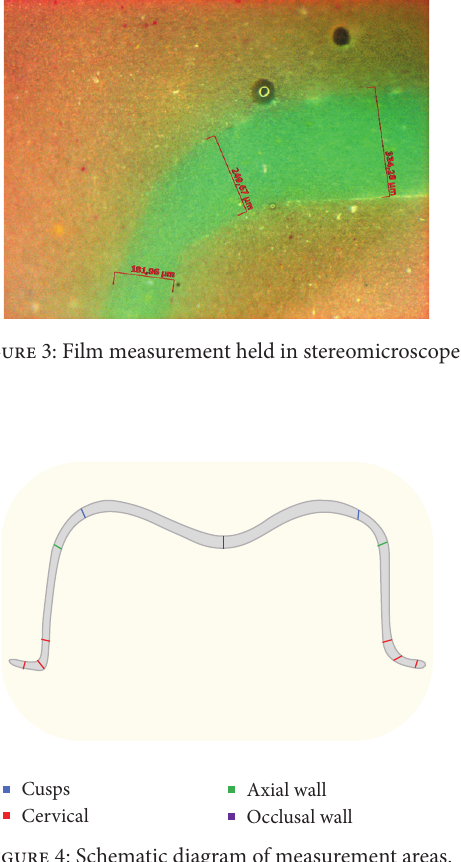
Figure 4: Schematic diagram of measurement